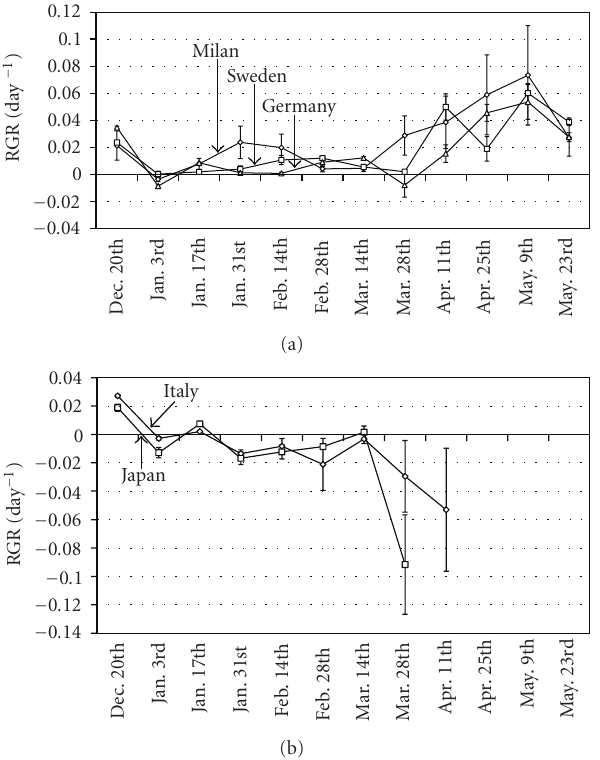
Figure 1: Fresh weight RGR (Relative Growth Rate) = (lnw 2 − lnw 1 )/( t 2 − t 1 ) of the five strains. Experiment started on Dec. 6th 2000. Every RGR is calculated on a two-week period, the end of which is reported in x -axis. Bars represent standard deviation. (a) A progressive decrease of leaf dimensions was registered in all strains, associated with accumulation of anthocyanins.